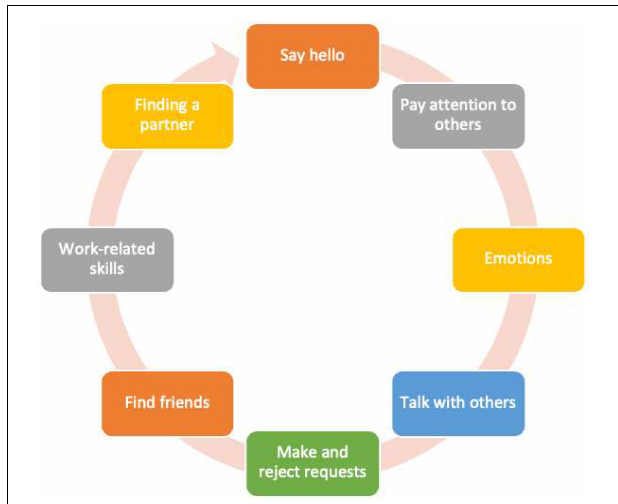
FIGURE 1 | Social skills training